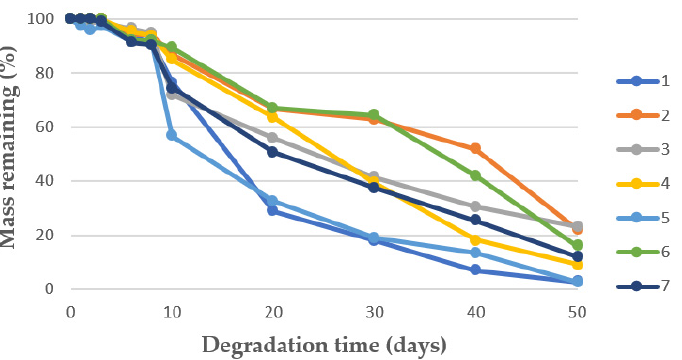
Figure 7. Mass remaining vs. degradation time in PBS solution of the scaffolds produced under different temperature levels.